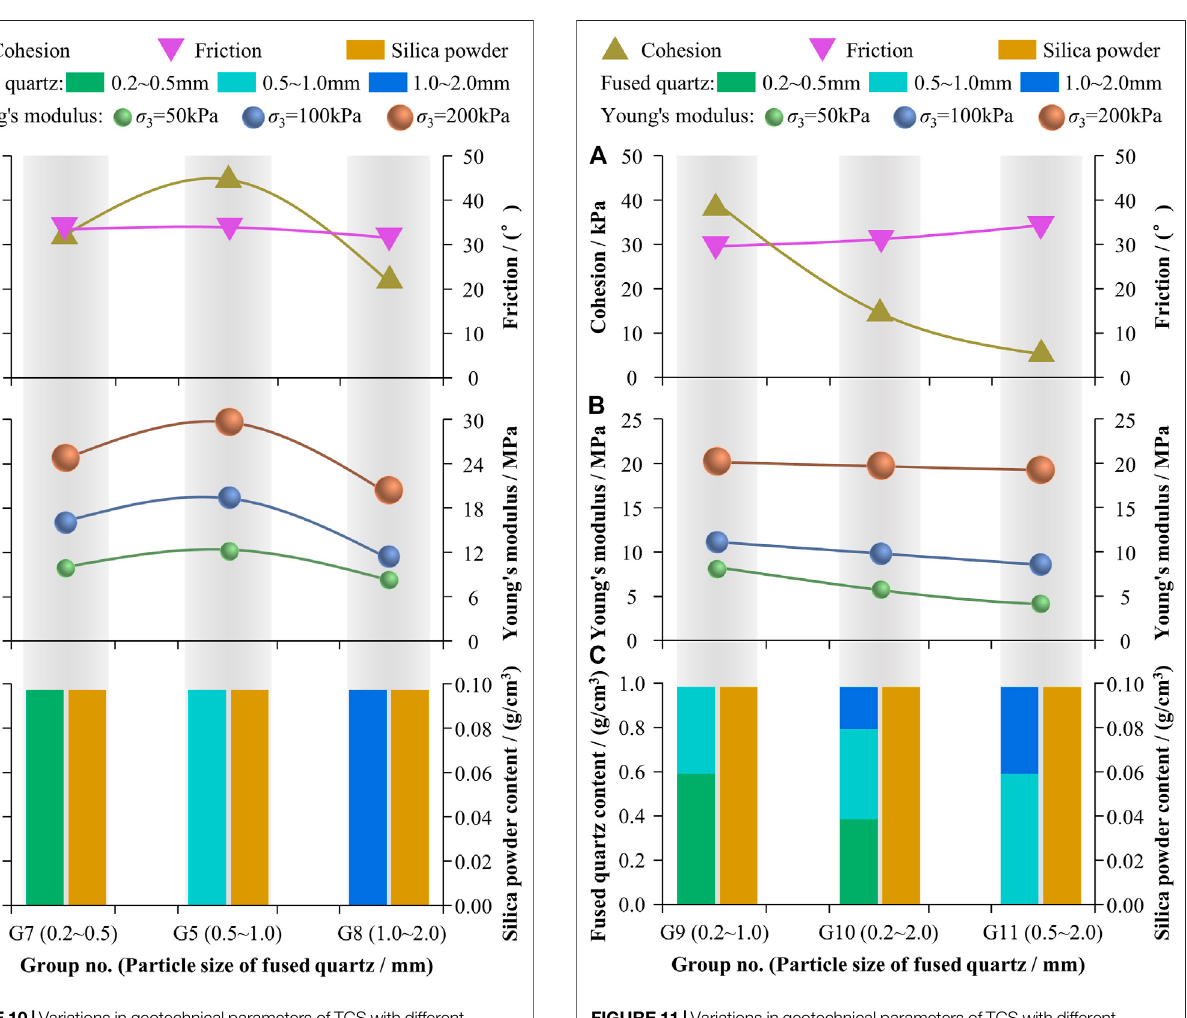
FIGURE10 | Variations in geotechnical parameters ofTCS withdifferent particle sizes of fused quartz.